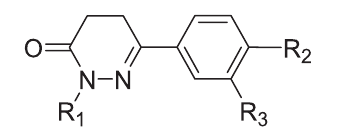
TABLE I - Structures of 6-aryl-2-(substituted amino-1yl)-2- methyl-4,5- dihydro ( 2H )-pyridazin-3-one derivatives ( 3a-j